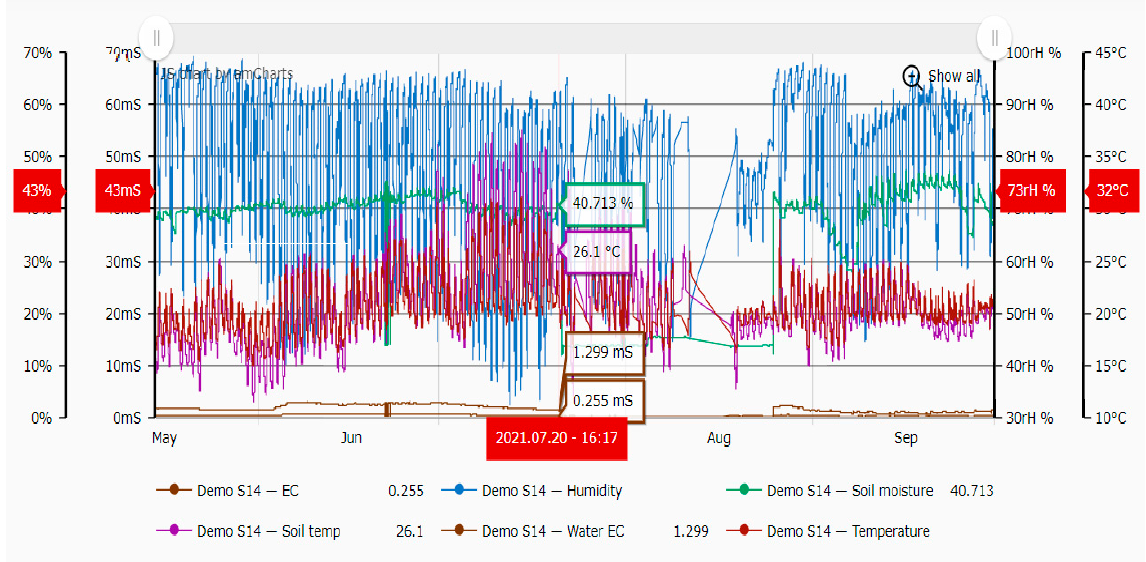
Figure 1. Microclimatological measurements for temperature, humidity, and water electroconductivity throughout the vegetation period.